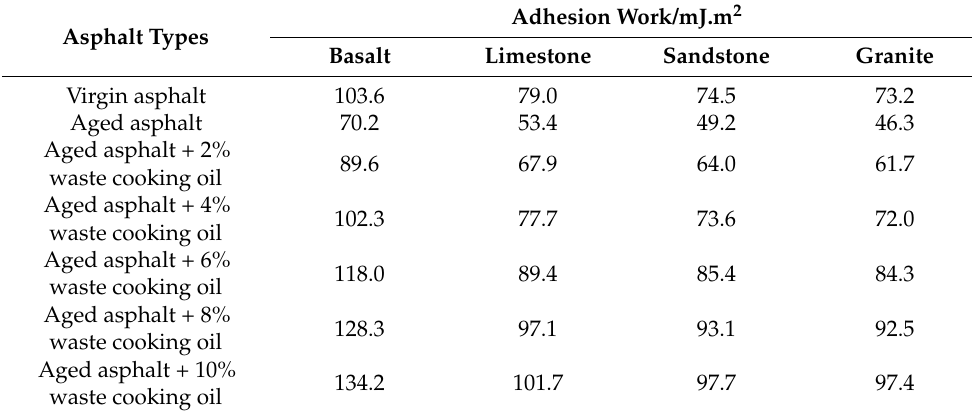
Table 13. Adhesion work between asphalt and aggregate